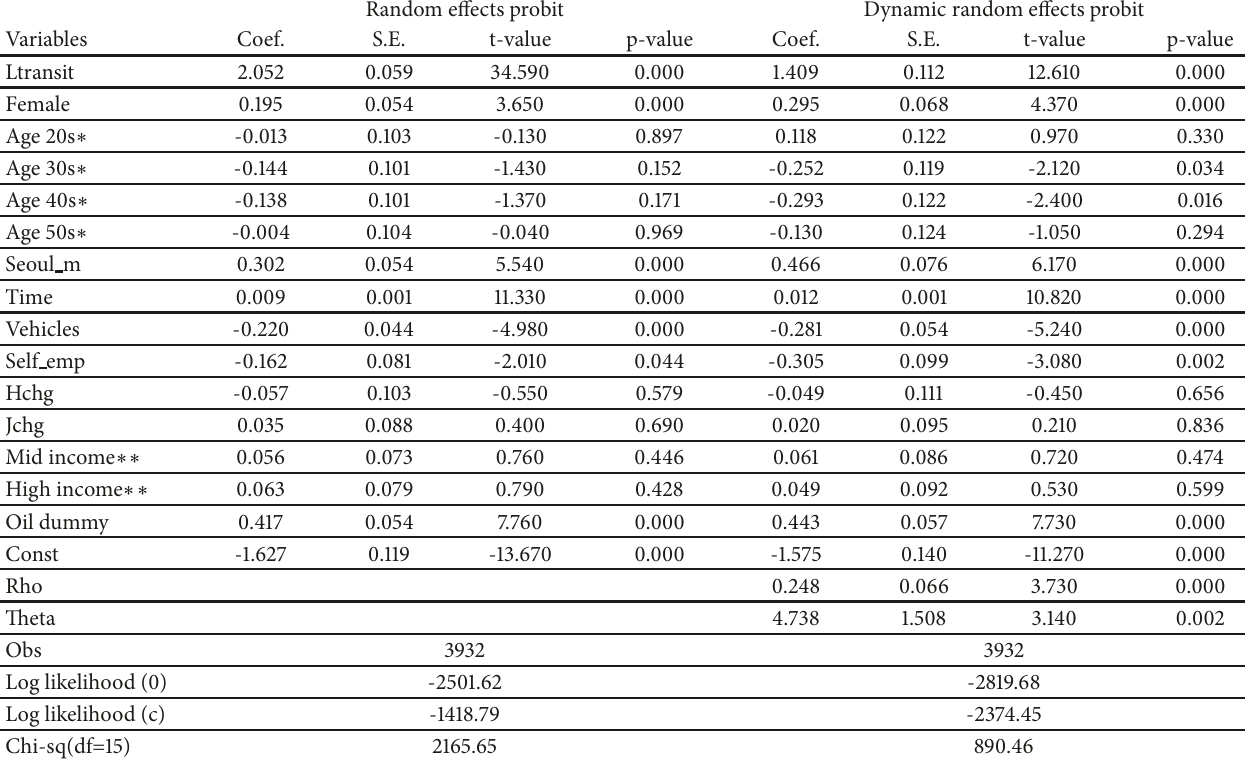
Table 7: Probit results of public transit